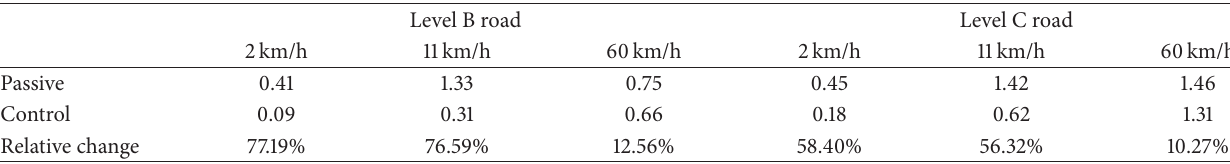
Table 2: Comparison of RMS values of sprung mass